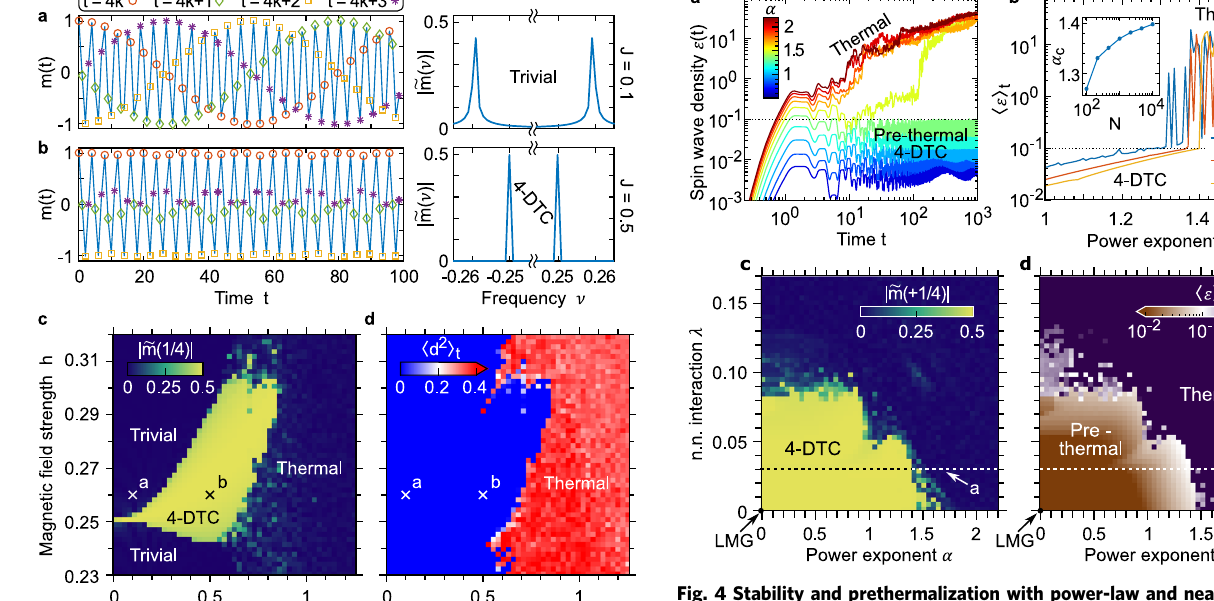
Fig. 4 Stability and prethermalization with power-law and nearest- neighbor interactions. The higher-order and fractional DTCs survive, most likely in a prethermal fashion, when deviating from the LMG limit. For concreteness, we focus on the 4-DTC at h = 0.27 and J = 0.5, and consider the effects of power-law ( α > 0) and nearest-neighbor ( λ > 0) interactions. a If the interactions are suf fi ciently long-range (that is α is small enough, here for a fi xed λ = 0.03), the density of spin-wave excitations ϵ remains small throughout several time decades. Conversely, shorter-range interactions lead to the proliferation of spin-wave excitations that makes the system quickly thermalize destroying any time crystalline order 15 . b A sharp transition between these two regimes is highlighted by the time average 〈 ϵ 〉 t over 10 3 periods versus α (at a fi xed λ = 0.03). The critical α c at which 〈 ϵ 〉 t crosses the threshold 0.1 (inset), grows and possibly saturates with the system size N , suggesting the stability of the 4-DTC in the thermodynamic limit N → ∞ . c , d The stability of the 4-DTC for a whole region of the parameter space surrounding the LMG point α = λ = 0 is highlighted plotting the magnitude of the subharmonic peak j ~ m ð 1 = 4 Þj and the average spin-wave density 〈 ϵ 〉 t in the ( α , λ )